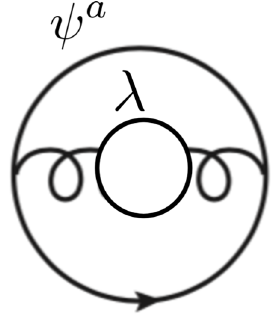
Figure 5 . In the determination of gauge holonomy potential, adjoint and fundamental fermions only start to couple at three-loop order in diagrams as above. However, as explained in the text, two-loop result will suffice for the determination of